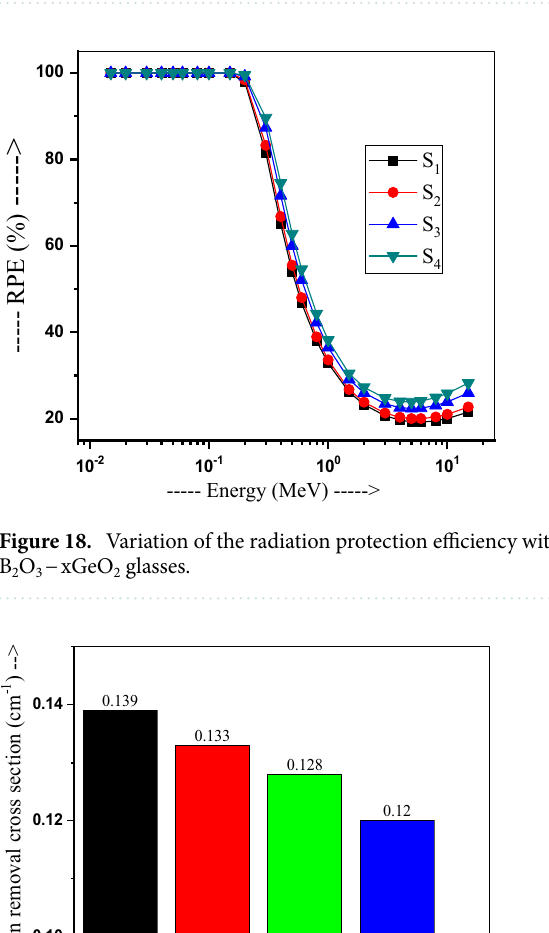
Figure 17. Variation of energy absorption buildup factor with energy for 20Bi 2 O 3 − xPbO − (80 − 2x) B